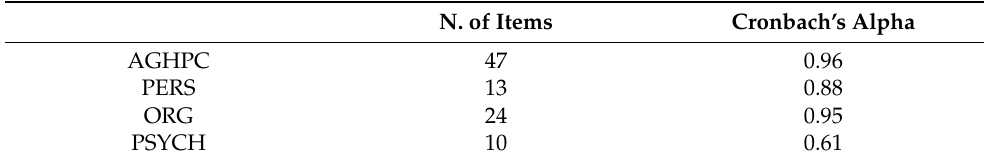
Table 4. Internal consistency (Cronbach’s alpha) for Adherence to Good Hospital Practices for COVID-19 and its domains ( n =